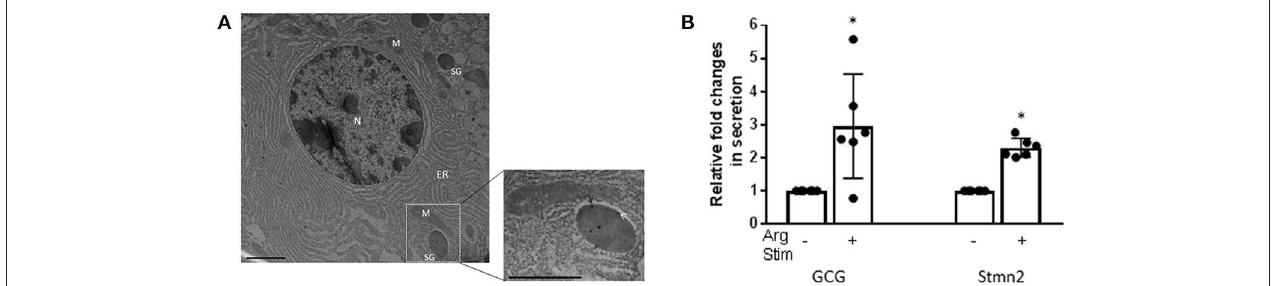
FIGURE 3 | Glucagon and Stmn2 are present within secretory granules of pancreatic α -cells. (A) Immunogold labels for both glucagon (10nm; white arrows) and Stmn2 (18nm; black arrows) are localized within secretory granules. The low magnification image (25,000 × , scale bar = 1 µ m) shows the ultrastructure of one alpha cell. N (nucleus); M (mitochondria); ER (endoplasmic reticulum); SG (secretory granule). The magnified image (41,000 × , scale bar = 0.6 µ m) highlights the presence of immunogold labels within a single secretory granule. (B) Isolated mouse islets were incubated in the presence or absence of 25mM Arg for 20min. Both glucagon and Stmn2 secretion from murine islets is stimulated by arginine. Values were normalized to the non-stimulated condition and expressed as mean ± SEM ( n = 5–6). * p < 0.01.